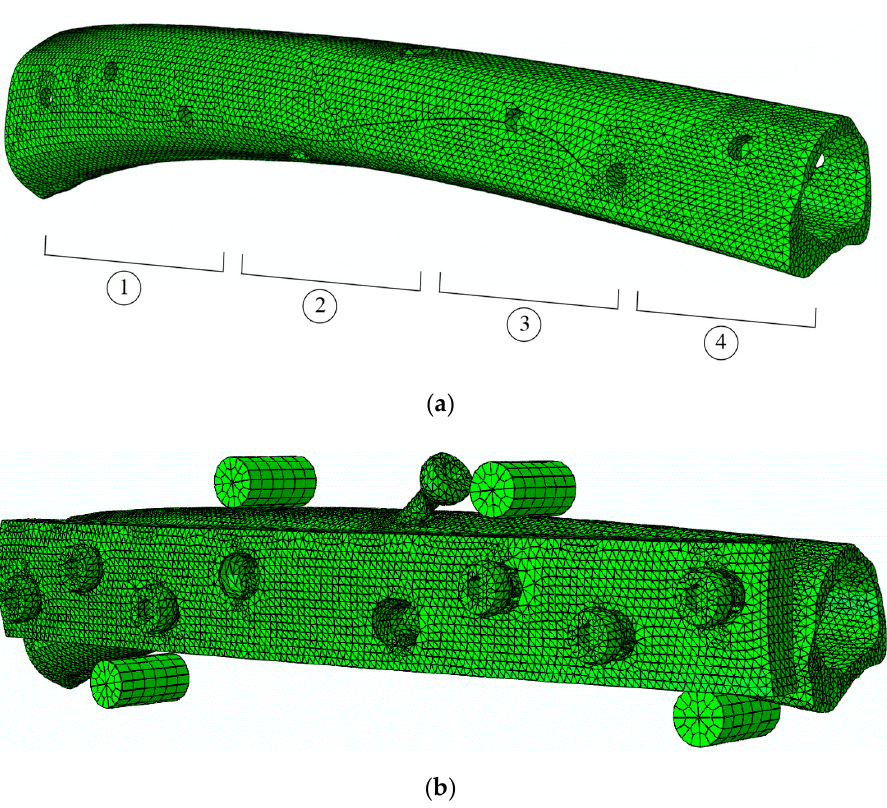
Figure 8. Finite element mesh ( a ) of the bone shaft (approximately 30 mm in length each) showing four (1 ‐ 4) regions to perform pull ‐ out strength tests, and ( b ) the four ‐ point bending (FPB)